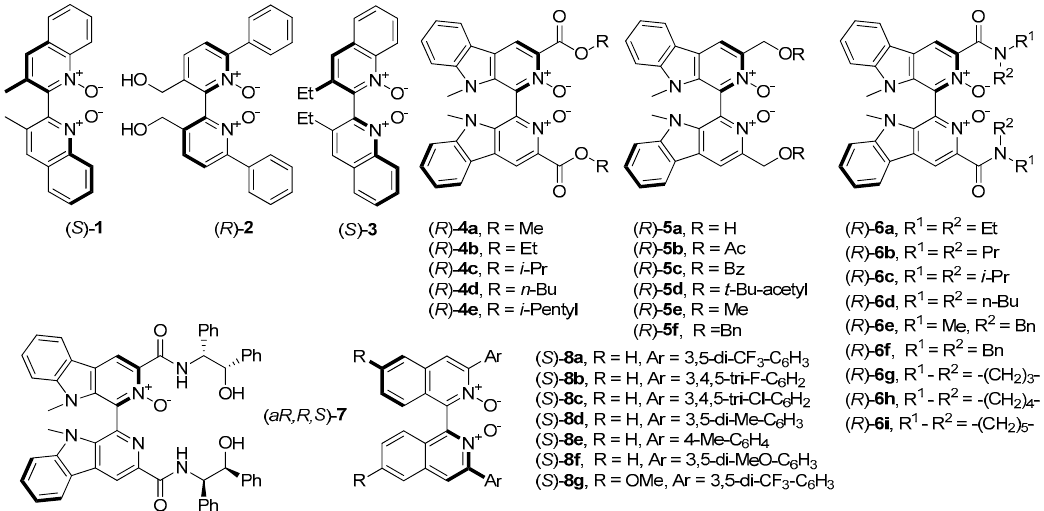
Figure 1. N -oxides possessing an axial element of chirality ( (aR , R , S) - 7 , which possess also central chirality is placed here due to the similarity of the structure).